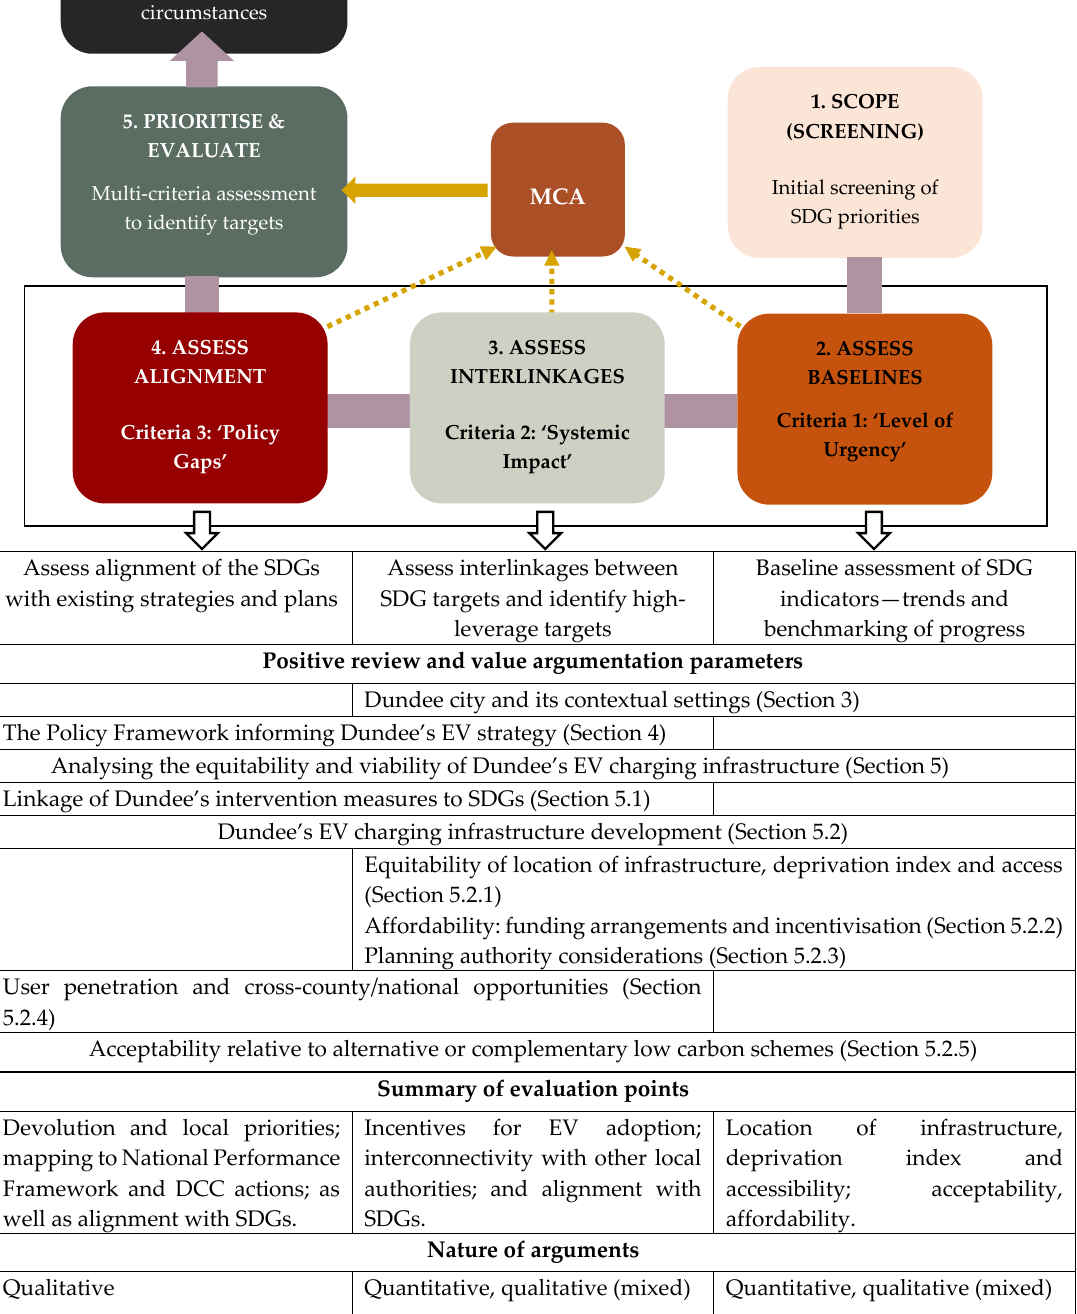
Figure 1. Positive review and value argumentation parameters linked to Sustainable Development Goal (SDG) prioritisation criteria. Top half: the multi-criteria analysis (MCA) of [18] (pp. 423–424); bottom half: adaptation of MCA for the positive review and value argumentation of Dundee’s electric vehicle (EV) strategy through evaluation against the MCA criteria: “level of urgency”, “systemic impact” and “policy